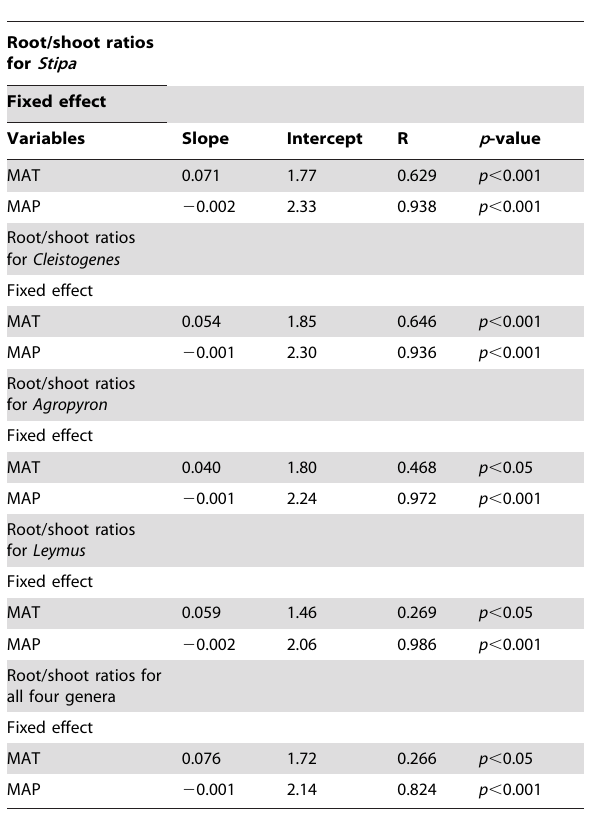
Table 3. Effects of MAT and MAP on root/shoot ratios of four dominant genera ( Stipa, Cleistogenes, Agropyron , and Leymus ) across a 2500-km long transect in northern China’s temperature grassland.